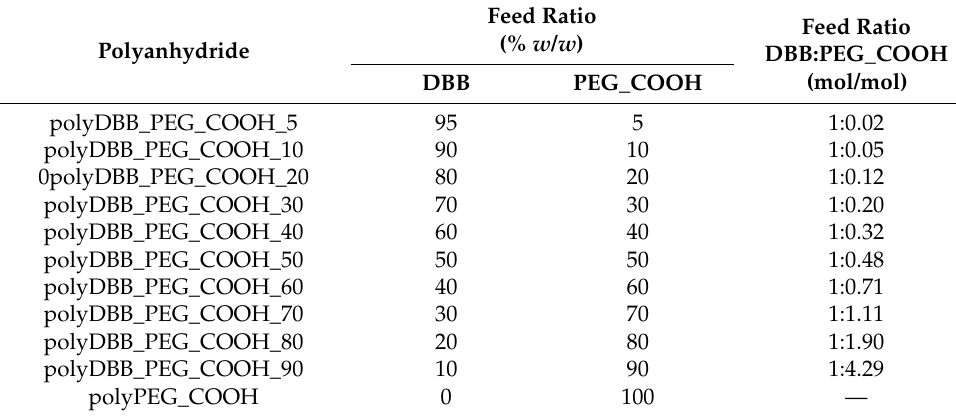
Table 4. Feed ratio of DBB and